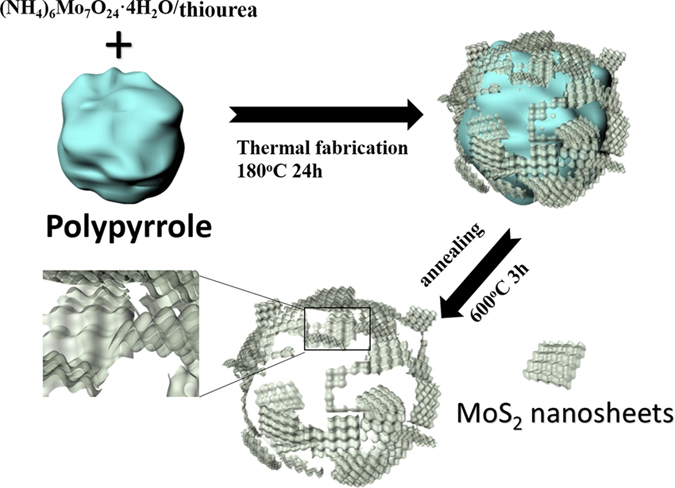
Schematic illustration of the morphological evolution process of the MoS2-P.